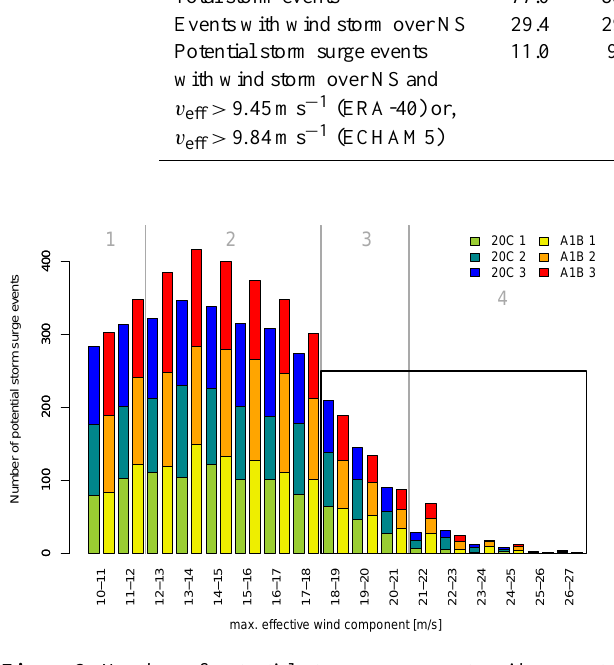
Figure 3. Number of potential storm surge events with respect to their maximum effective wind component over the German Bight region for the three ensemble members of the 20C (1901– 2000, green to blue) and A1B (2001–2100, yellow to red) period. Grey bars denote the boundaries of the four categories used in Sect. 4.2. The black rectangle indicates those potential storm surge classes, which are used for the extreme value statistic described in Sect.